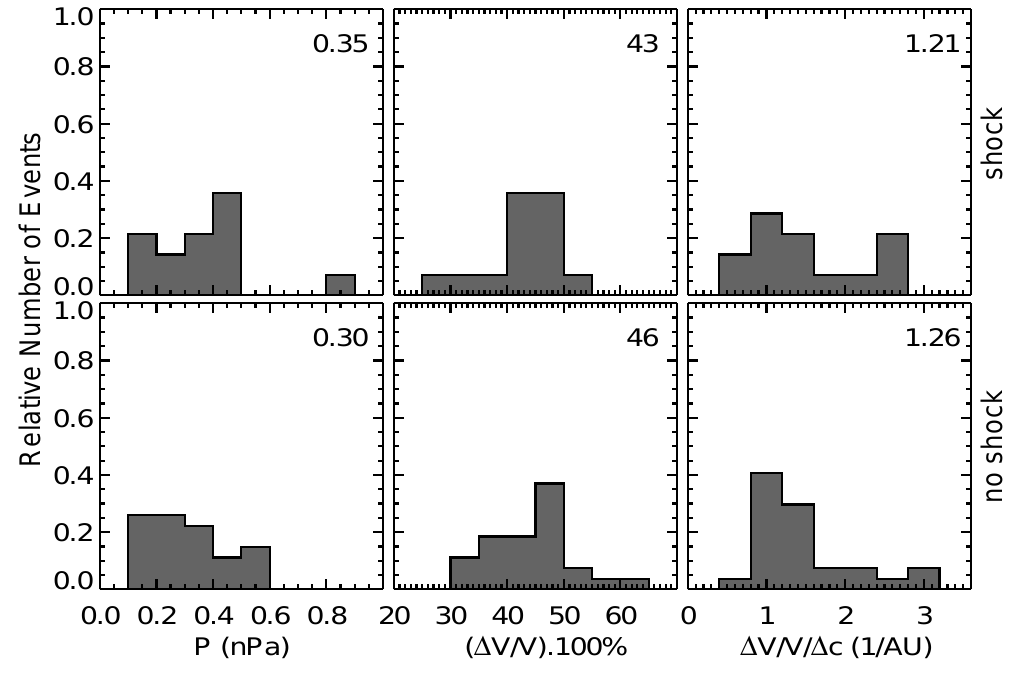
Fig. 5. Histograms of peak pressures (left), relative flow-speed changes (middle panel) and relative flow-speed changes per width of the compression region (right panel) for CIRs with simple streams. The medians are shown in the upper right